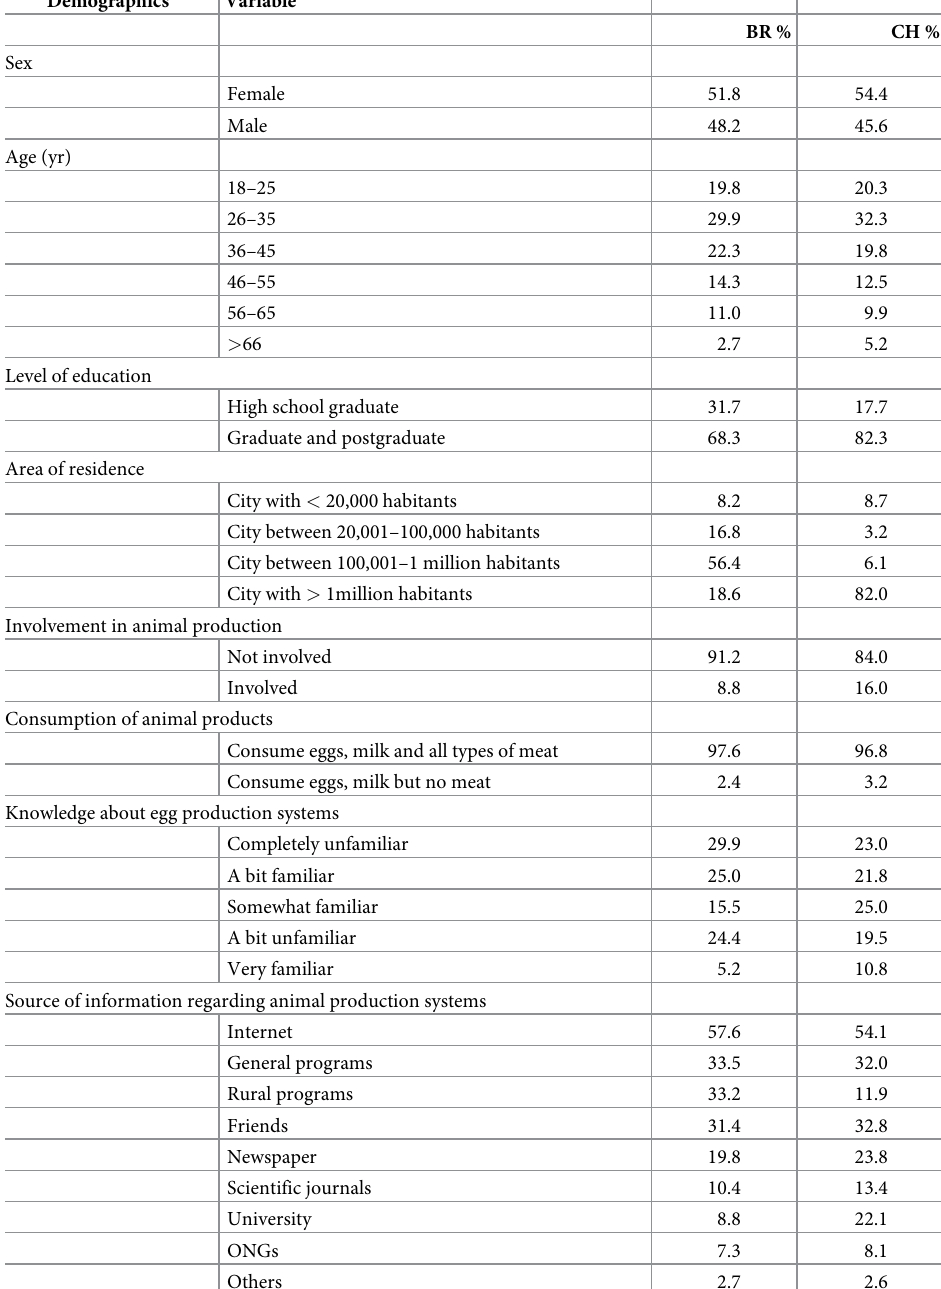
Table 1. Demographic data (in percentage) of the cohorts (Brazilian participants [BR] and Chilean participants [CH]) that participated in the survey (n = 672).